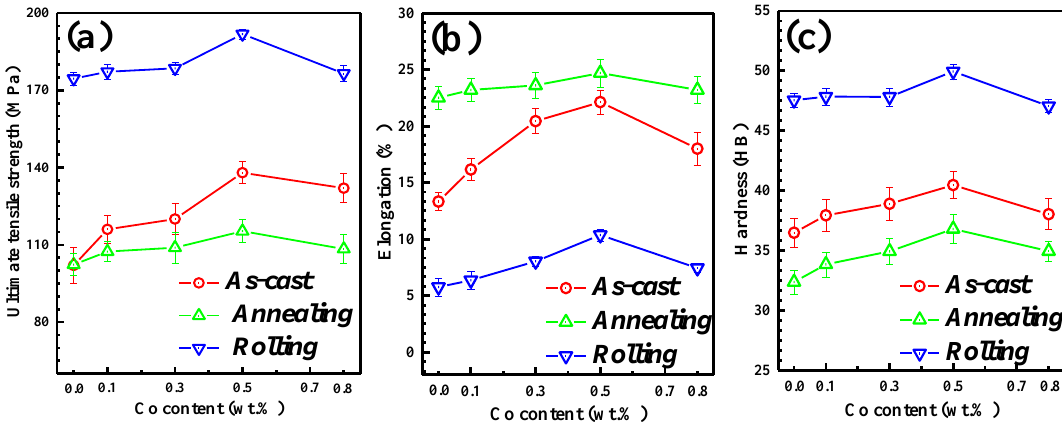
Figure 9. The mechanical properties of Al-2Fe with different Co contents in different states: ( a ) Ultimate tensile strength, ( b ) Elongation, ( c ) Hardness.